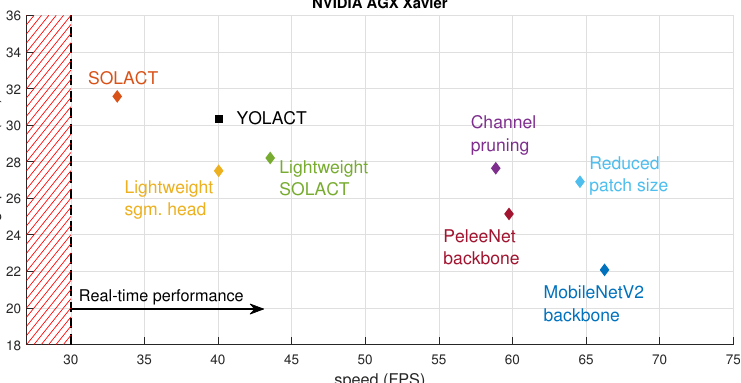
Figure 12. Speed-vs.-performance trade-off, where the models are deployed on the AGX Xavier